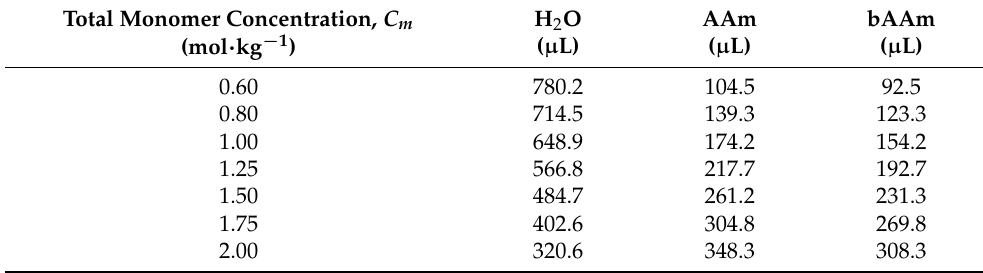
Table 1. Hydrogel